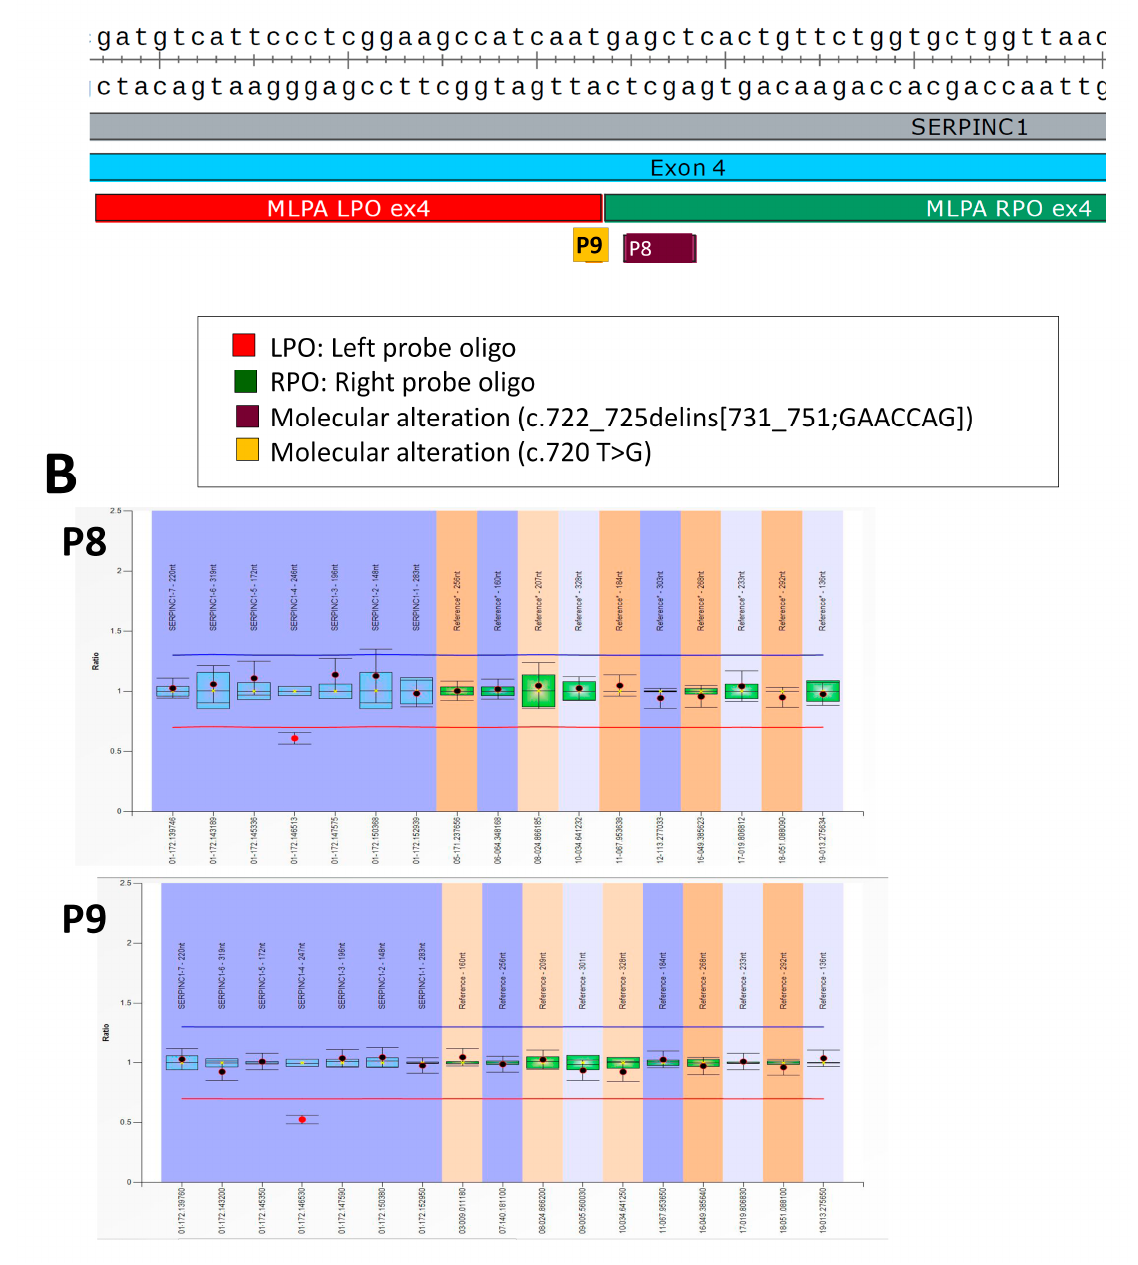
Figure 5. Genetic defects identified in patients P8 and P9: ( A ) localization of the small complex INDEL identified in P8 and the SNV of P9; and positions of MLPA probes covering exon 4 of SERPINC1 ; ( B ) MLPA results obtained in P8 and P9. In both cases, MLPA incorrectly identified a heterozygous deletion of exon 4.